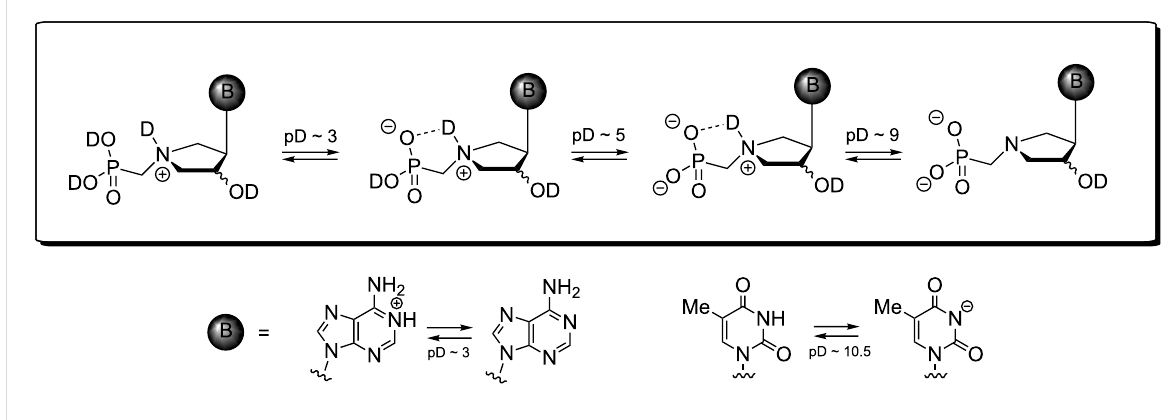
N-1 at pD ~ 3 while thymine releases its deuterium at N-3 at pD ~ 10.5 and becomes negatively charged. Typically, a pD value of 5.7–6.9 was reached when 50 mM solutions of 7–10 in D 2 O were prepared for the NMR measurement, which indicates that isolated compounds are in the form of the monosodium monozwitterionic salt.